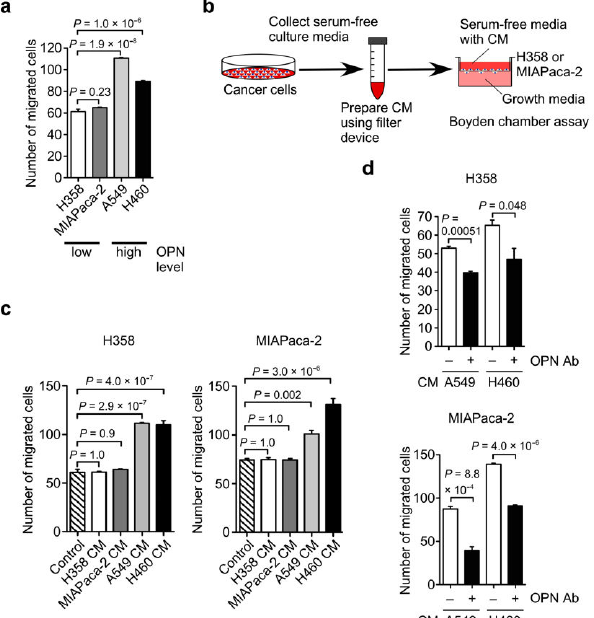
Figure 2. Effect of endogenous OPN secreted from cancer cells on cancer cell migration. ( a ) Migration activity of H358, MIAPaca-2, A549, and H460 cells. One-way ANOVA and Tukey post-hoc test, mean ± SEM of three independent assays conducted in triplicate. ( b ) Schematic procedure of the cell migration assay using conditioned culture media (CM) from cancer cells. ( c ) The effect of the CM from H358, MIAPaca-2, A549, and H460 cells on the cell migration of H358 and MIAPaca-2 cells. PBS was used as a sample instead of CM in the control experiments. One-way ANOVA and Tukey post-hoc test, mean ± SEM of three independent assays conducted in triplicate. ( d ) Effect of OPN function blocking antibody (OPN Ab) on the cell migration of H358 and MIAPaca-2 cells induced by the CM from A549 and H460 cells. – and + indicate CM without and with OPN Ab treatment, respectively. Two-tailed unpaired Student’s t -test, mean ± SEM of three independent assays conducted in triplicate.